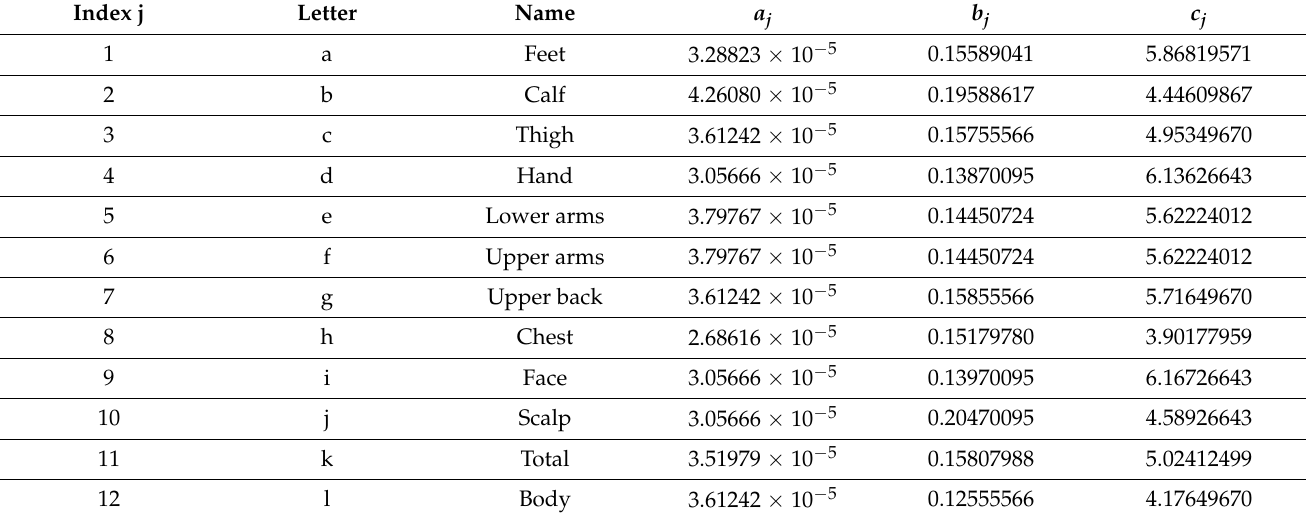
Table 3. Body segments assignment by index, letter, and